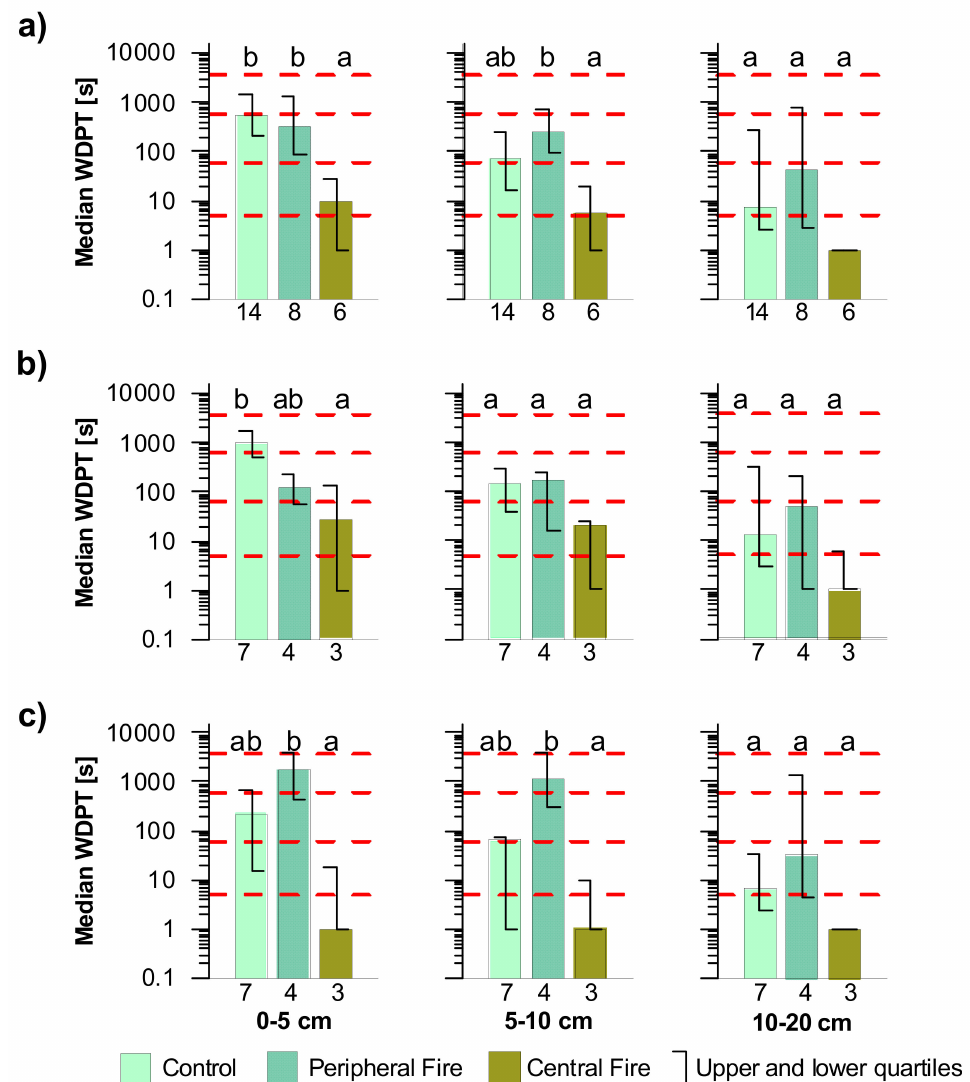
Figure 1. Median value of Water Drop Penetration Time (WDPT) test with upper and lower quartiles for ( a ) all soil samples, under ( b ) old and ( c ) young pine stand on the control site, and in the areas of a peripheral fire and central fire for three soil depths: 0–5 cm, 5–10 cm and 10–20 cm. Note: di ff erent letters above columns denote significant di ff erences in each depth, as determined with the Kruskal–Wallis test ( α < 0.05). Di ff erent numbers below columns denote n, the number of replications. Red dashed lines denote the soil water repellency (SWR) classes: 0—wettable or non-water repellent, WDPT ≤ 5 s; 1—slightly repellent, 5 s < WDPT ≤ 60 s; 2—strongly repellent, 60 s < WDPT ≤ 600 s; 3—severely repellent, 600 s < WDPT ≤ 3600 s; and 4—extremely repellent, WDPT > 3600